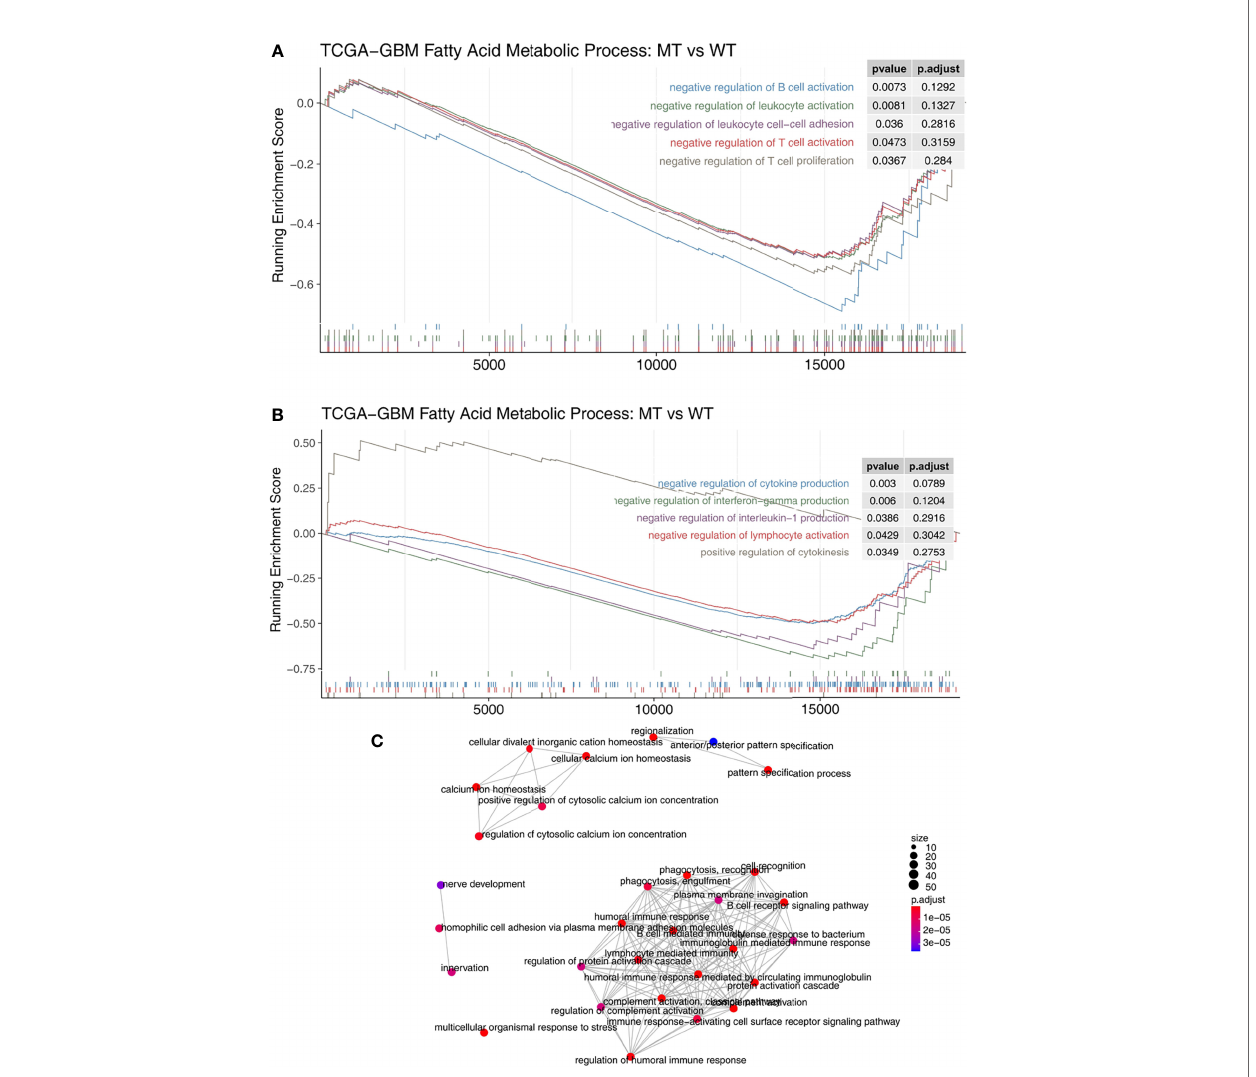
FIGURE 5 | (A) The gene sets enrichment analysis showed that the enrichment scores of the immune cells were signi fi cantly up-regulated in the fatty acid metabolic process of the MT group. (B) The gene sets enrichment analysis showed that the enrichment scores of cytokine production were signi fi cantly up-regulated in the fatty acid metabolic process of the MT group. (C) The emapplot representing the connection between the immune-related signaling pathways. MT,